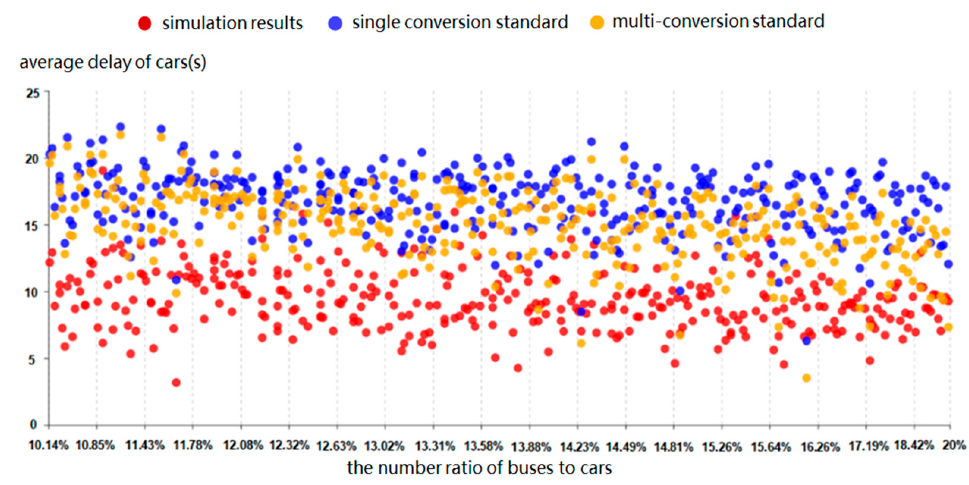
Figure 6. Average delay of cars.